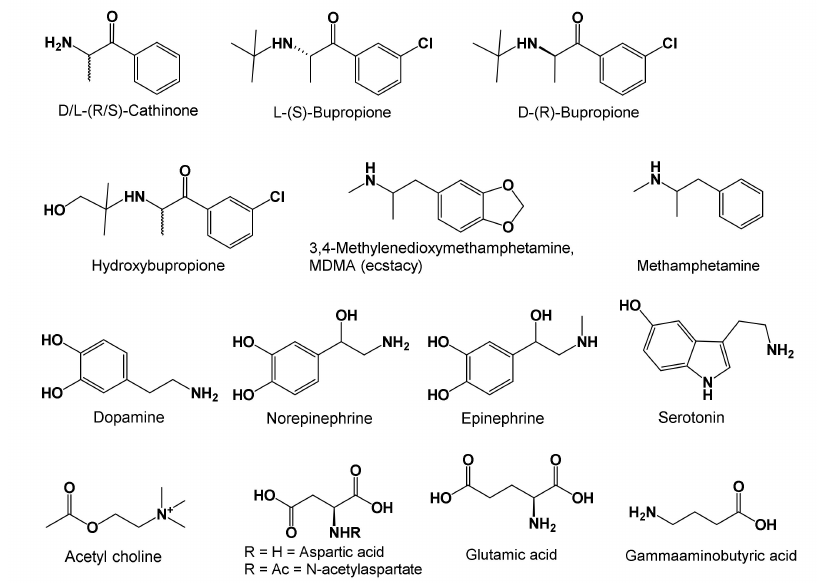
Figure 3. Structures of cathinone, bupropions, amphetamines, and of neurotransmitters as discussed in the text and in Box 1